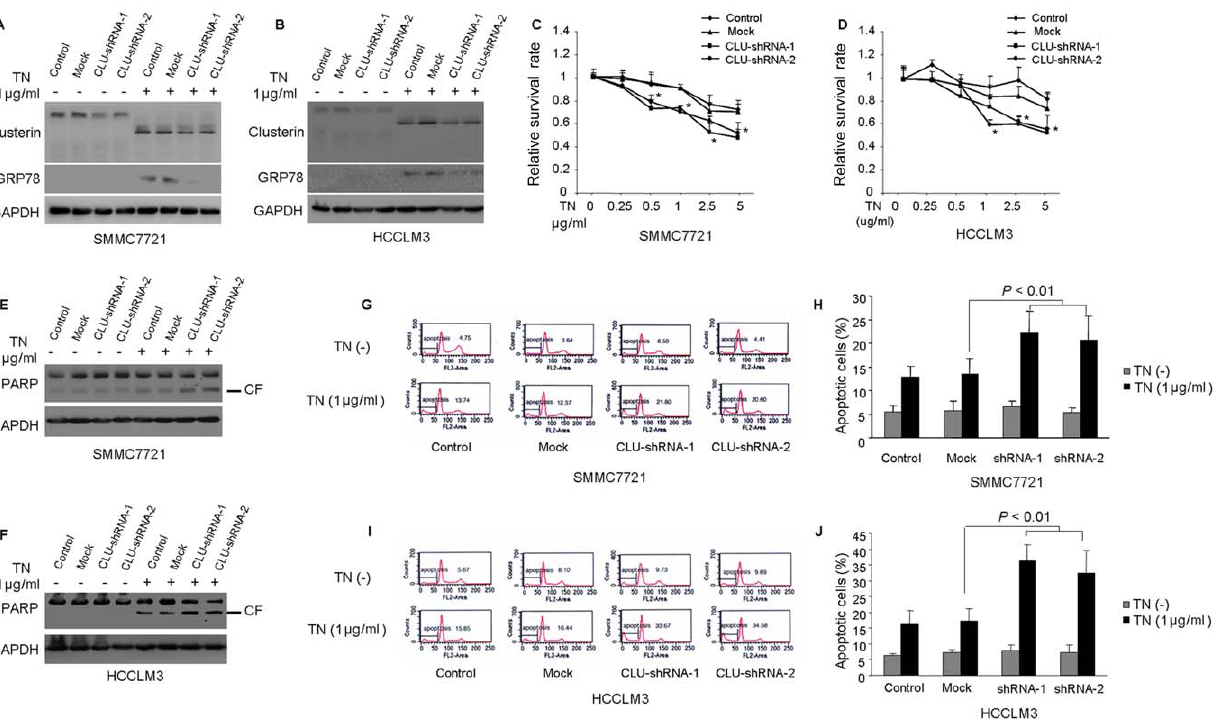
Figure 2. CLU knockdown enhances TN treatment induced apoptosis in SMMC7721 and HCCLM3 cells. (A–B) SMMC7721 and HCCLM3 cells were infected twice for a total of 2 days (1 day for each infection). The expression of CLU in SMMC7721 and HCCLM3 cells were inhibited through lentivirus-mediated shRNA interfering followed by 1 m g/ml of TN treatment for 24 h. Protein extracts were analyzed for CLU, GRP78 and GAPDH. (C– D) CCK8 assay was performed to determine cell viability after TN treatment with indicated concentrations for 24 h. The results indicated a synergistic effect of CLU knockdown with TN treatment. The values of relative survival rate were normalized with untreated cells. * P , 0.05, versus mock group. TN-induced cell apoptosis in SMMC7721 and HCCLM3 cells were measured by Western blot analysis of PARP cleavage (CF, cleaved form) (E–F) and flow cytometry (sub-G1) (G–J). All these data were from a representative experiment and the representative result was from at least three independent